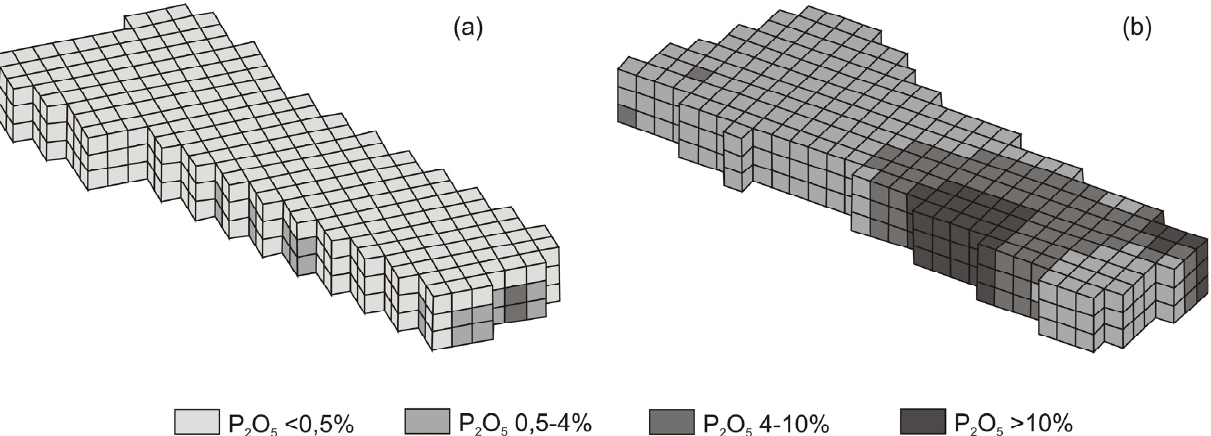
Figure 2. Distribution of the useful component in the block model of a drilling-and-blasting block based on the data analysis of: ( a ) core drilling boreholes; ( b ) drilling cuttings.